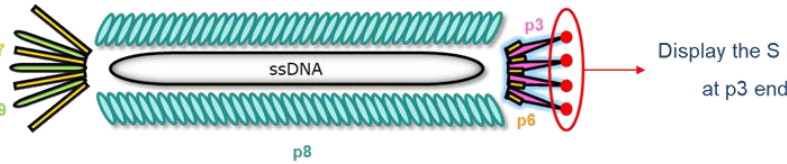
Table 8. Conditions for double digestion preparation [45].